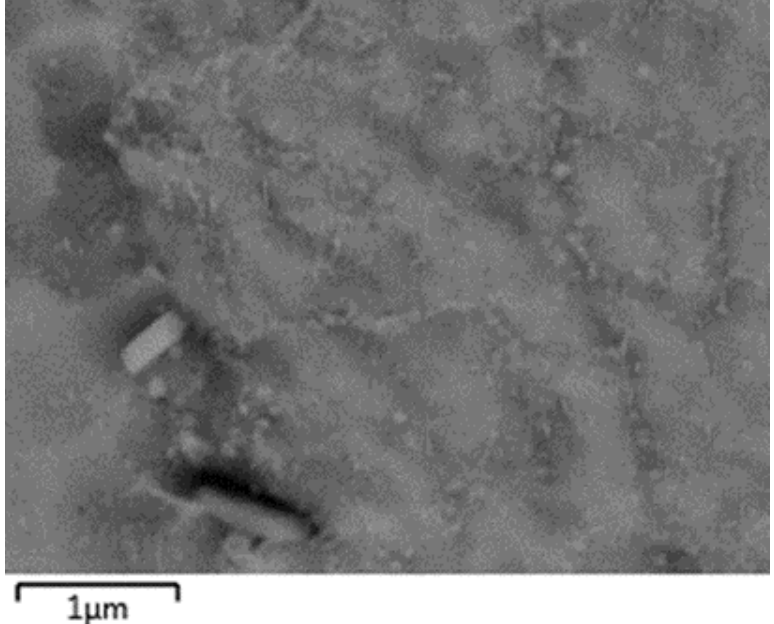
Figure 8. Microstructure at 7500× of cellular IN718 after 10 h of aging using backscattered electrons. This image was used for chemical mapping.